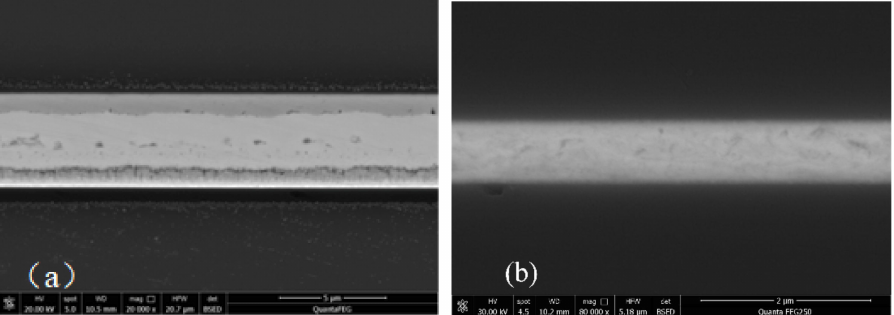
Figure 15. SEM images of the stored interfacial structure. ( a ) Cu–Sn bonding. ( b ) Au–Au bonding.